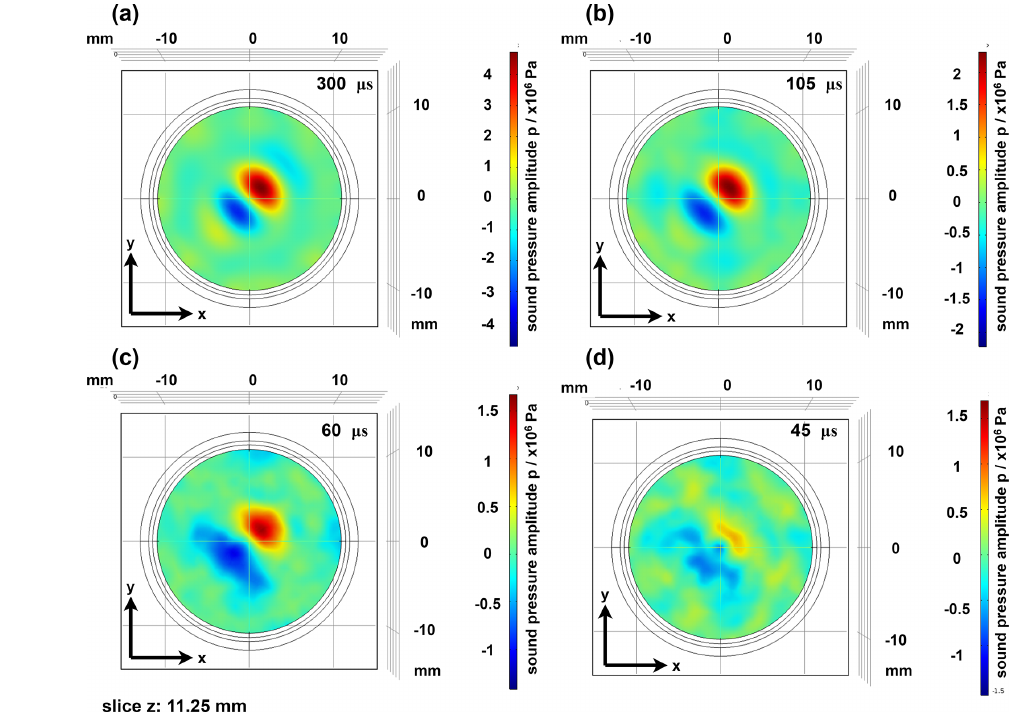
Figure 4. Representation of the sound pressure field in the x – y plane as a function of the signal length of the time reversal signals. Signal lengths: (a) 300µs, (b) 105µs, (c) 60µs and (d)